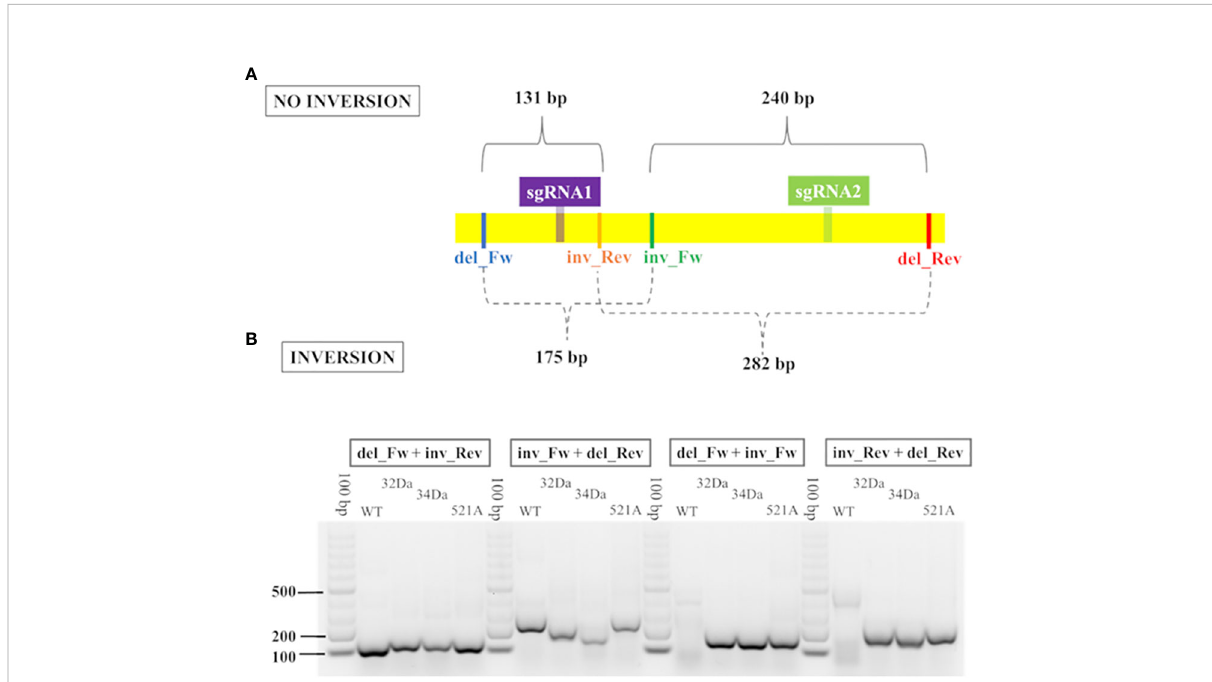
FIGURE 2 Validation of potential inversion via PCR. (A) Graphical representation of primers incorporated into the region subjected to potential inversion. Each primer del_Fw and del_Rev was coupled with inv_Fw and inv_Rev, for a total of four different combinations. The length of the amplicons produced by each combination is indicated. (B) Gel electrophoresis displays the PCR amplicons obtained through the four primer combinations, used to con fi rm the potential inversion. WT corresponds to ‘ Doppio sanguigno ’ wild type, 32Da and 34Da are the codes of ‘ Doppio sanguigno ’ plantlets, 521A is the code of the ‘ Bud Blood ’